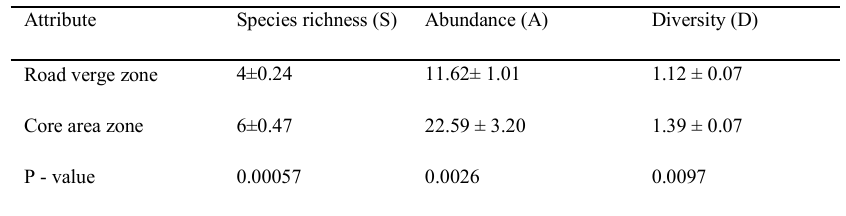
Table 1: Community composition